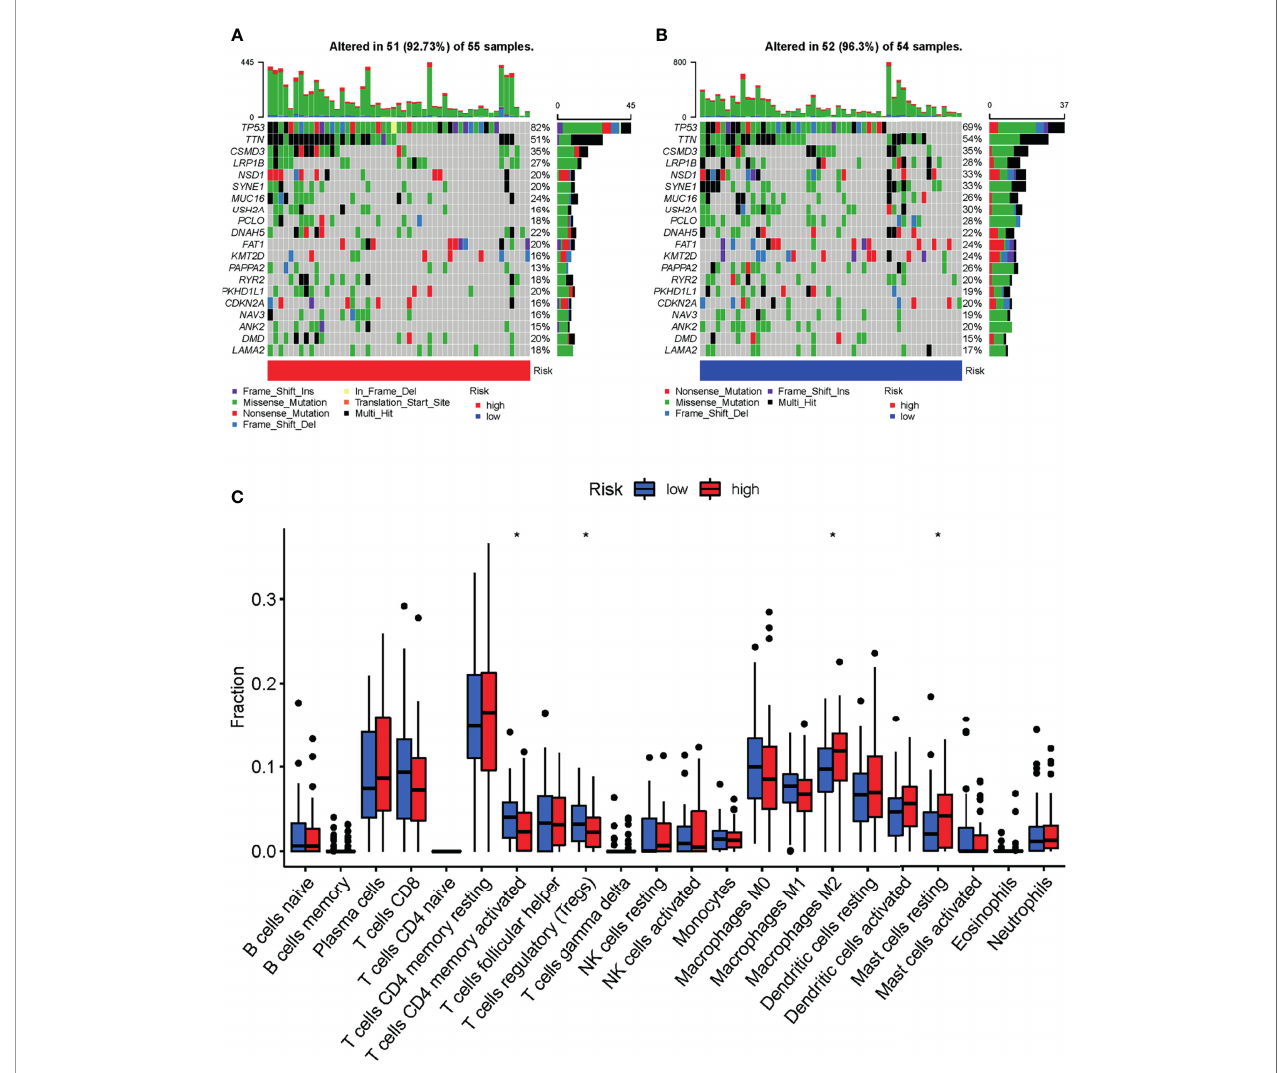
FIGURE 5 | Landscape of mutation pro fi les and tumor-in fi ltrating immune cells abundance between high and low-risk LSCC patients. Waterfall plots represent mutation information in each sample of the (A) high- and (B) low-risk group of TCGA-HNSC-Larynx dataset. (C) The difference of 22 tumor-in fi ltrating immune cells between the high- and low-risk group of TCGA-HNSC-Larynx dataset. * p < 0.05; LSCC, lung squamous cell